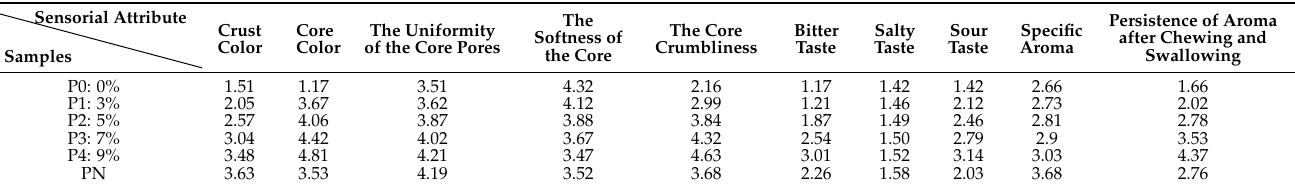
Table 10. Summary of scores obtained by the panel evaluation of bread samples with the addition of